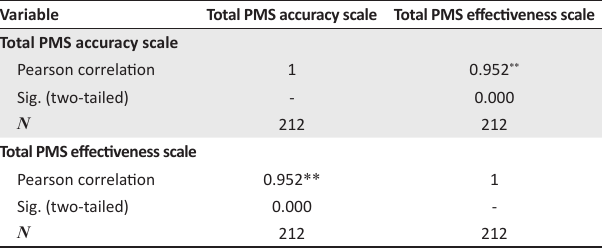
TABLE 9: Correlation between performance management system accuracy and fairness scales.